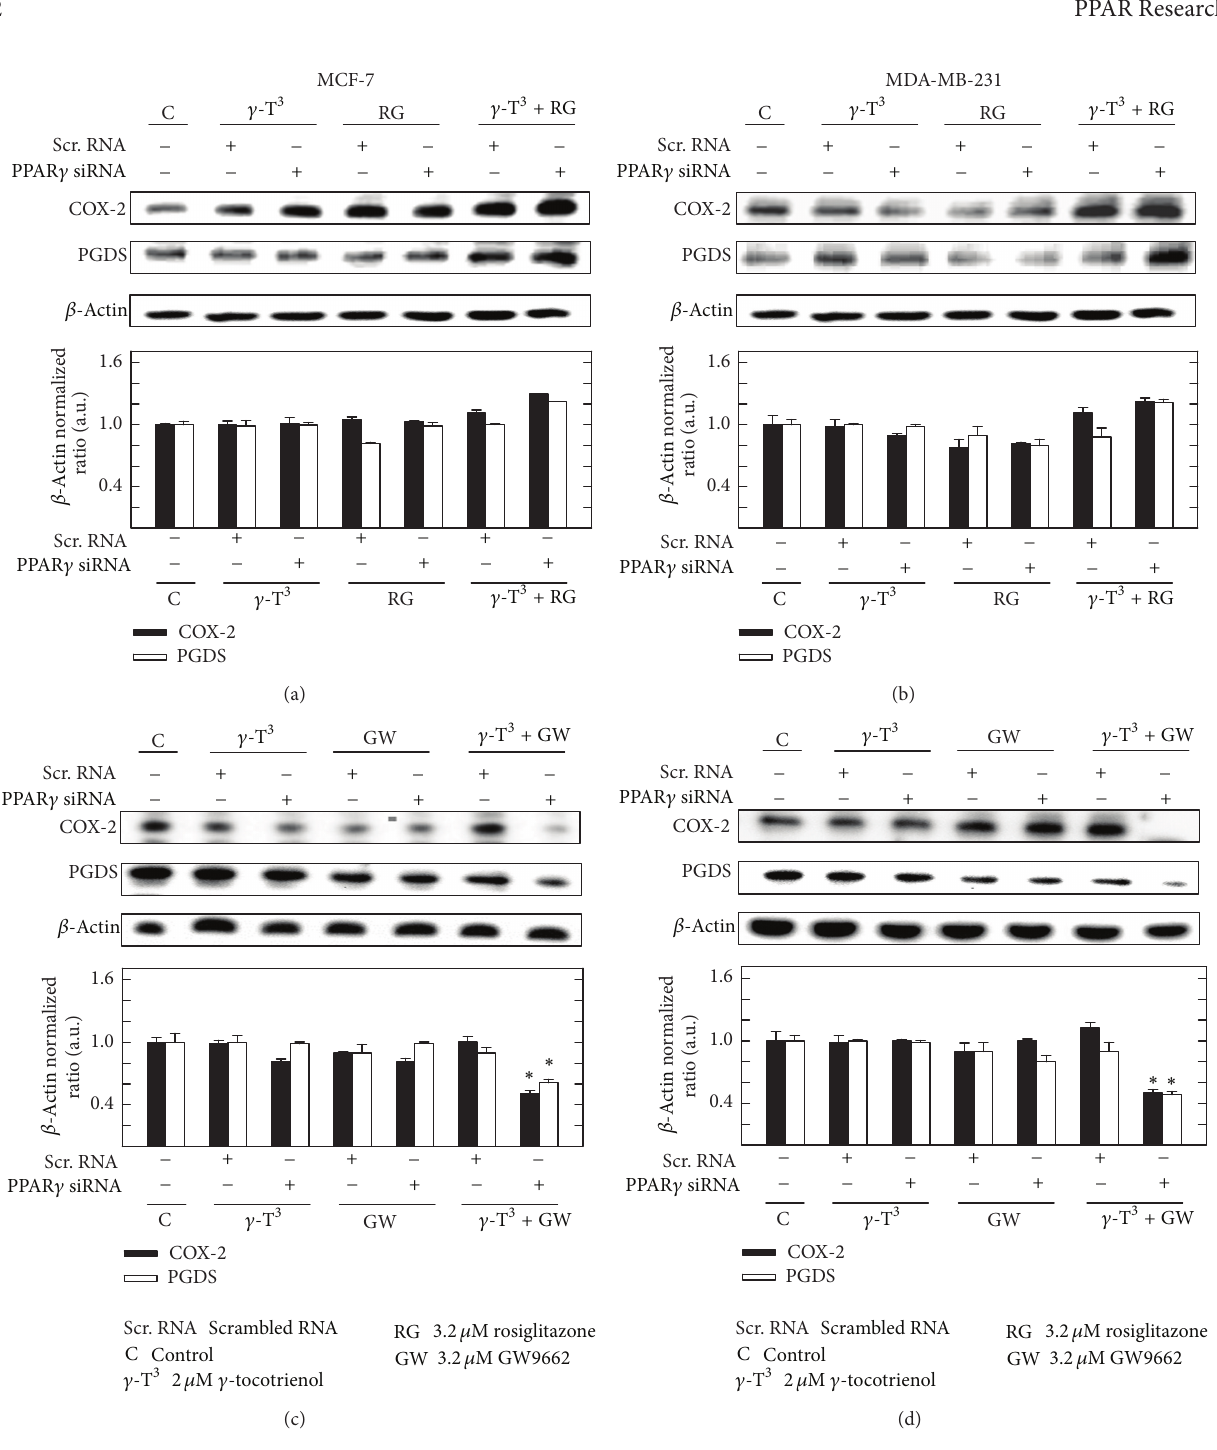
Figure 9: Western blot was performed to determine effect of treatment of 𝛾 -tocotrienol and rosiglitazone alone or in combination in PPAR 𝛾 siRNA transfected (a) MCF-7 and (b) MDA-MB-231 cells. In addition, Western blot was performed to determine effect of treatment of 𝛾 - tocotrienol and GW9662 alone or in combination in PPAR 𝛾 siRNA transfected (c) MCF-7 and (d) MDA-MB-231 cells. Cells were plated at a density of 2 × 1 0 5 cells/well (3 replicates per group) in 6-well plates in 2 mL antibiotic-free media. Transfections were performed using 5 𝜇 L lipofectamine 2000 according to the manufacturer’s protocol. Briefly, for each well to be transfected, 100pmol of the scrambled or PPAR 𝛾 siRNAs was diluted with 2 mL of media. After 6h transfection, the medium was replaced with fresh growth media containing 10% FBS and cells were cultured for 18h. Cells were then exposed to control or treatment media for a 4-day culture period. Afterwards whole cell lysates were prepared from each treatment group for subsequent separation by polyacrylamide gel electrophoresis (50 𝜇 g/lane) followed by Western blot analysis. Scanning densitometric analysis was performed on all the blots done in triplicate and the integrated optical density of each bond was normalized with corresponding 𝛽 -actin, as shown in bar graphs below their respective Western blot images. Vertical bars in the graphs indicate the normalized integrated optical density of bands visualized in each lane ± SEM (arbitrary unit). ∗ 𝑃 < 0.05 as compared with vehicle-treated